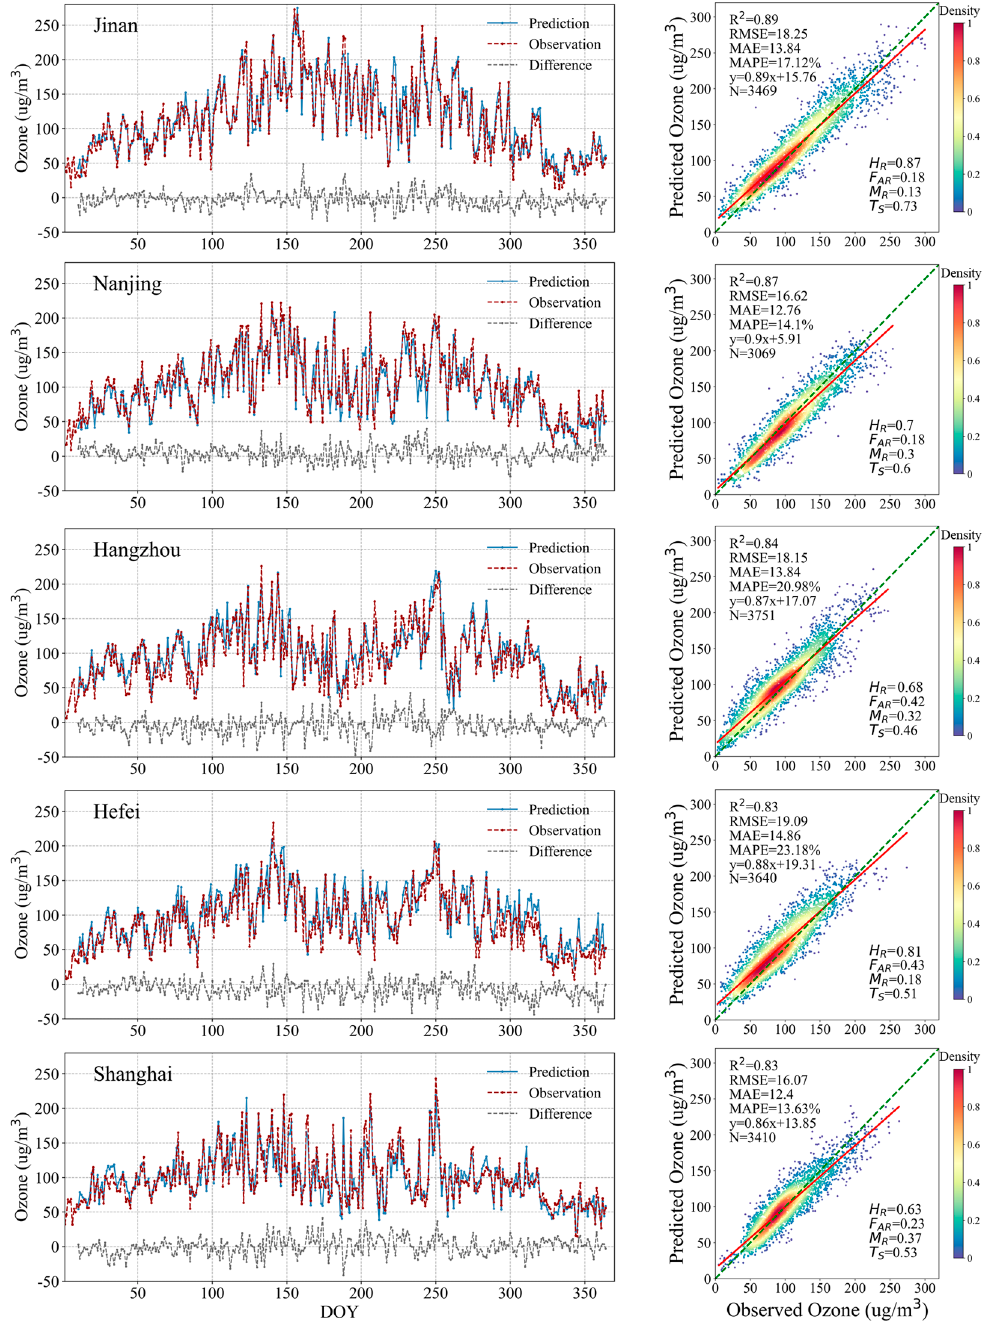
Figure 7. Time series plots of predictions and observations by our model in Jinan, Nanjing, Hang- zhou, Hefei, and